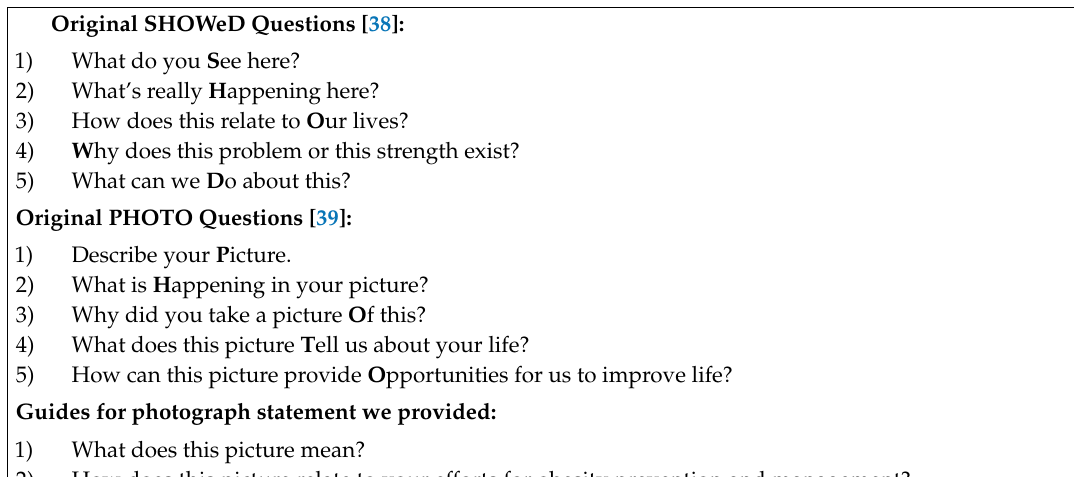
Box 1. Questions for short statement per each